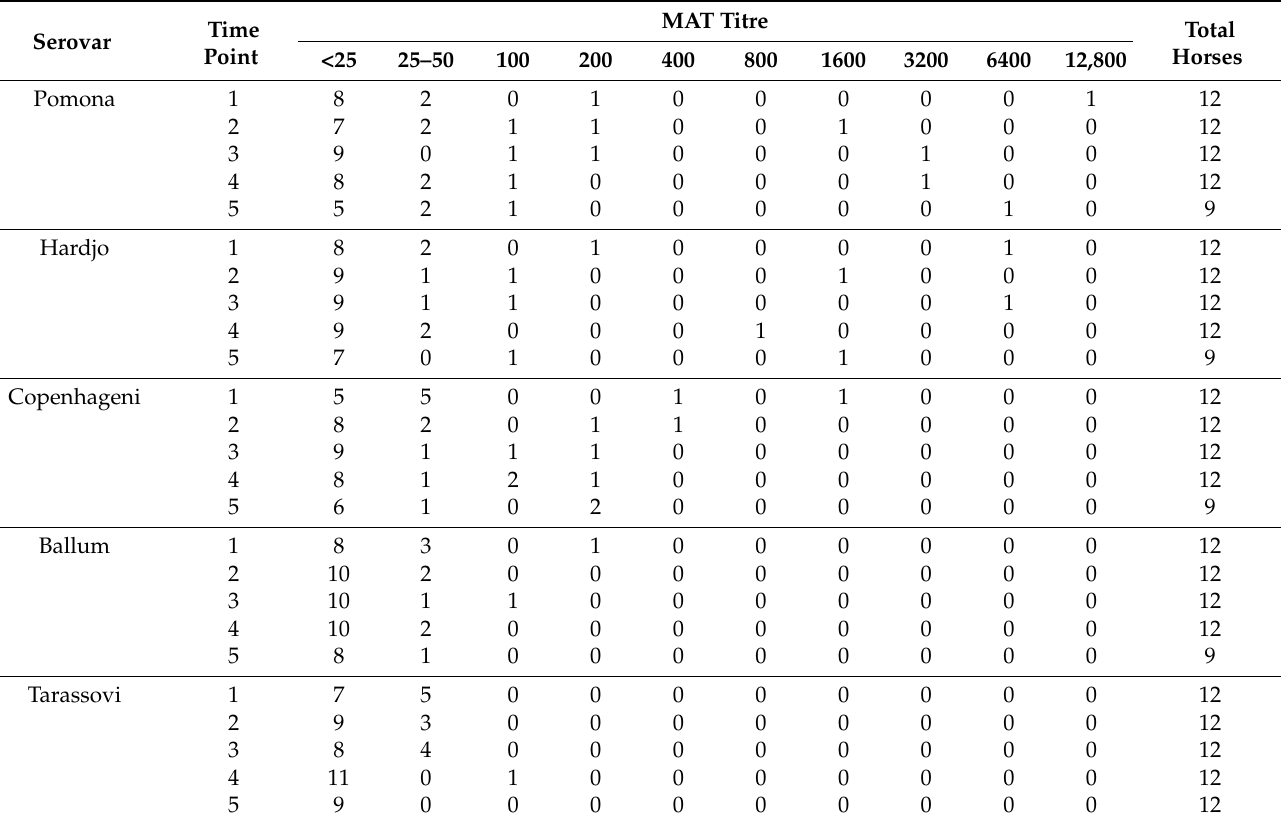
Table 3. Number of horses by MAT titre for each serovar at each sampling time point in a group of horses tested for Leptospira antibodies, which were located near to outbreak of leptospirosis in alpacas.